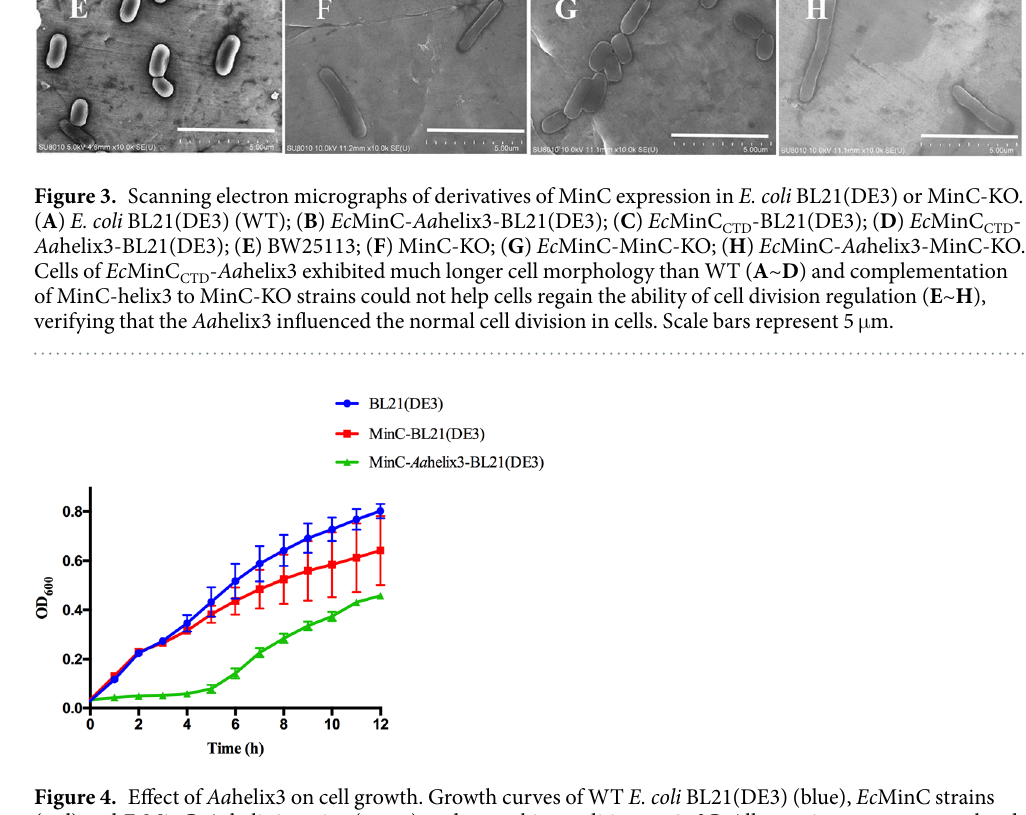
Figure 4. Effect of Aa helix3 on cell growth. Growth curves of WT E. coli BL21(DE3) (blue), Ec MinC strains (red) and Ec MinC- Aa helix3 strains (green) under aerobic conditions at 37 °C. All experiments were completed in triplicate and performed twice. The standard error of the mean was used to calculate the error bars. For those points where experimental variations are too small, their error bars are not visible.